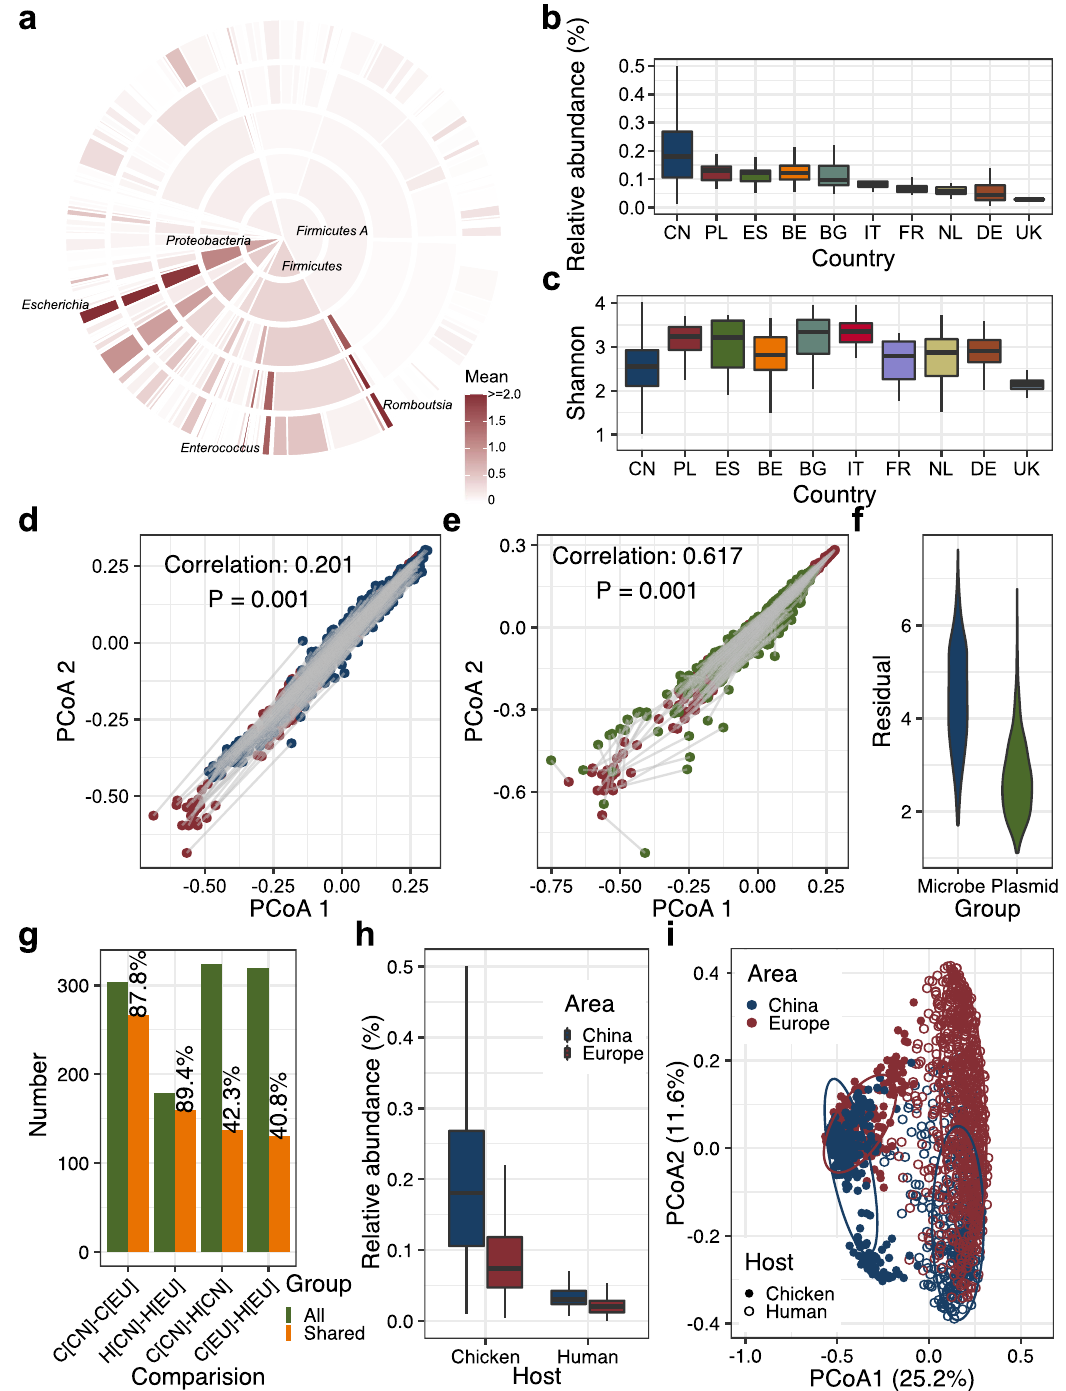
Fig. 4 Pro fi ling the antibiotic resistome in the chicken gut microbiome. a Number of ARGs in MAGs at different taxonomic levels. The inner to outer portions represent the phylum level to the genus level. The color represents the mean values of ARGs in speci fi c taxa. b Relative abundance of ARGs in samples from different countries. c Shannon index of ARGs in samples from different countries. d Procrustes analyses of the correlation between the microbial abundances and the ARG abundances. Red dots: ARG abundances; blue dots: microbial abundances. e Procrustes analysis of the correlation between the plasmid and ARG abundances. Red dots: ARG abundances; green dots: plasmid abundances. f Violin plot of the residuals from the Procrustes analyses in d , e . g Proportion of ARGs shared among microbiomes. C[CN], C[EU], H[CN], and H[EU] denote Chinese chicken samples, European chicken samples, Chinese human samples, and European human samples, respectively. h Relative abundance of ARGs in the chicken and human gut microbiomes. i Principal coordinate analysis (PCoA) based on the Bray – Curtis distance of the ARG abundance in chickens and humans from China and Europe. CN